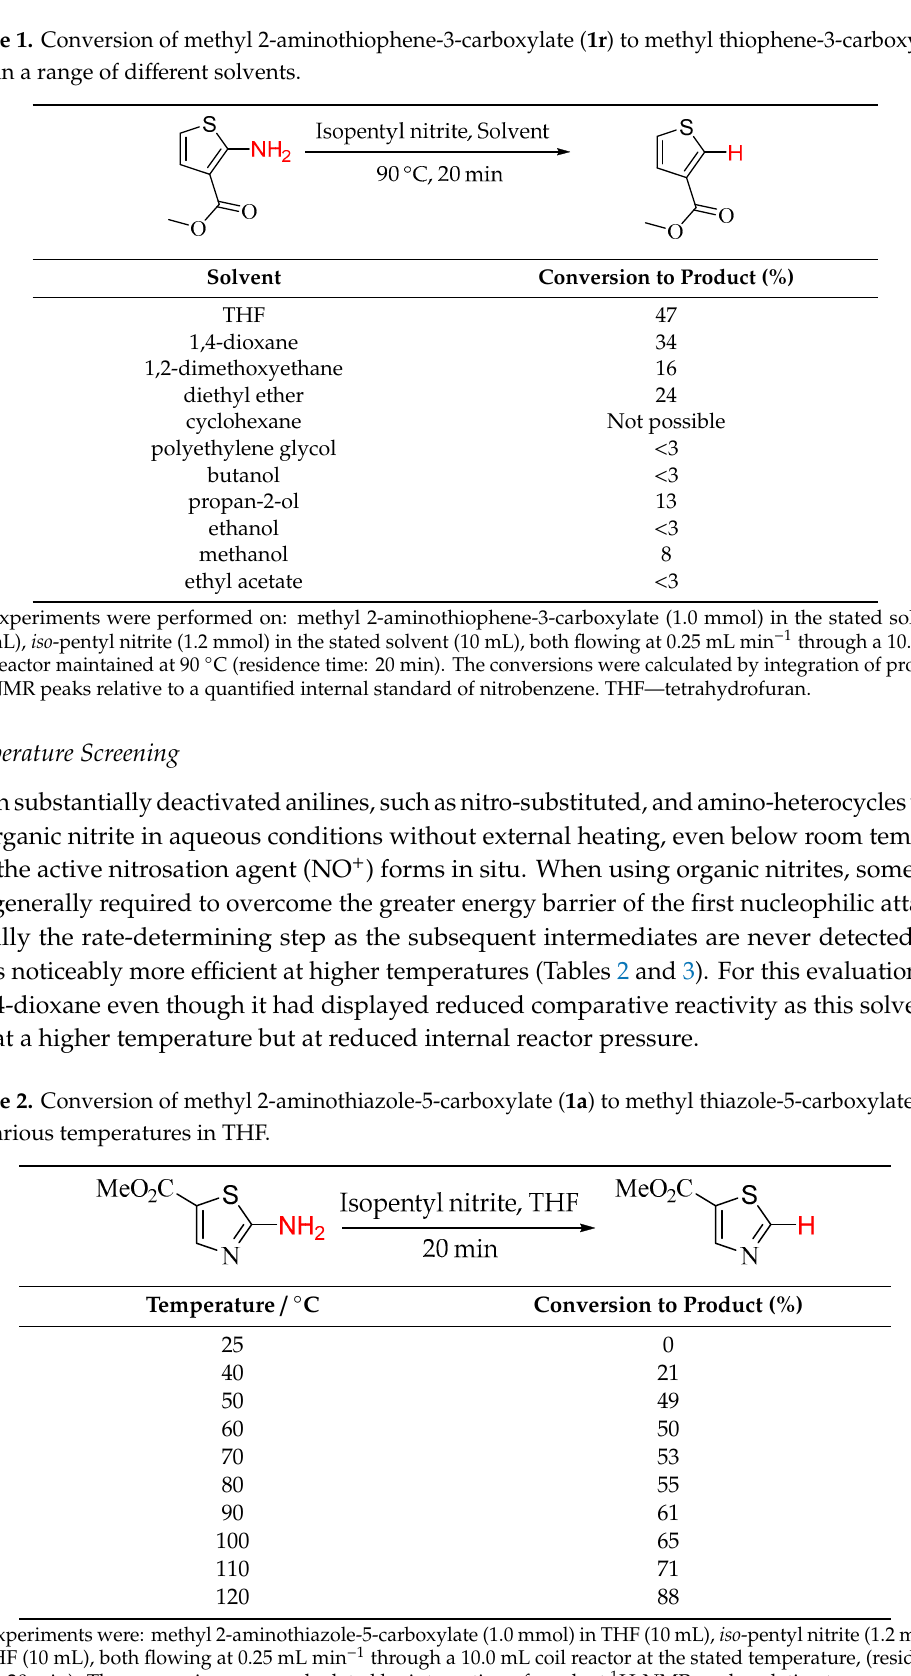
Table 1. Conversion of methyl 2-aminothiophene-3-carboxylate ( 1r ) to methyl thiophene-3-carboxylate ( 2r ) in a range of different solvents.